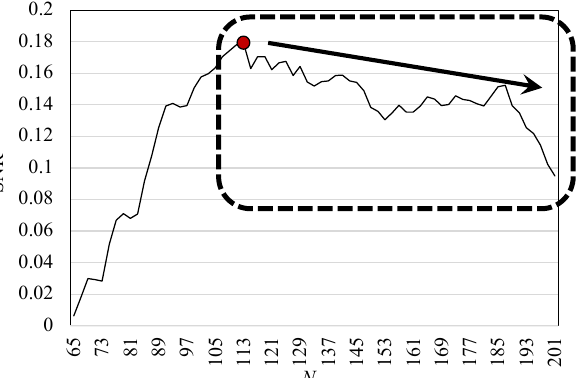
Figure 19. Expanded view of the SNR variation with the kernel size N = 65–201. The reason for the slow decrease in SNR from SN AVF = 0.179 ( N = 113) can be explained by the fact that the reversed- phase waveform at the side of the anastomosis is also averaged as the kernel size N